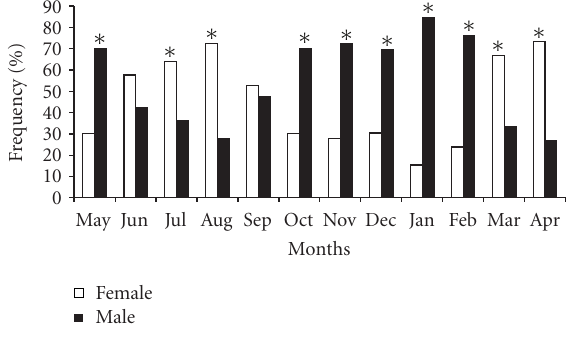
Figure 2: Monthly sex ratio of Prochilodus brevis ( ∗ χ 2 , P < 0 . 05).